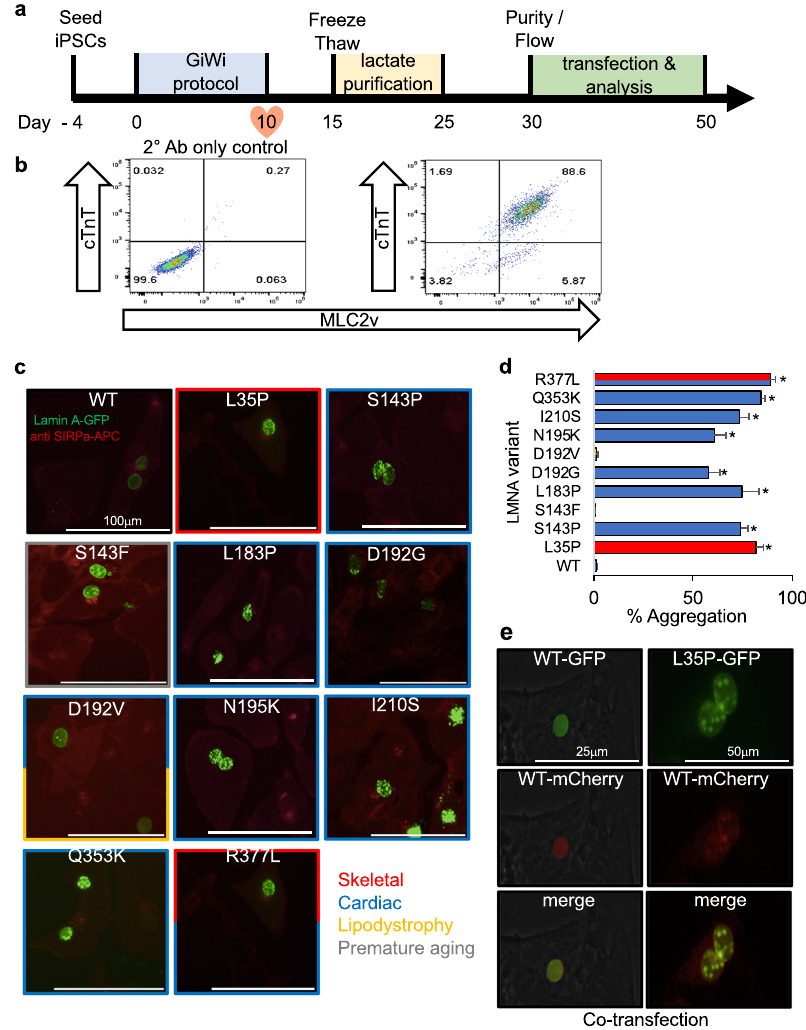
Fig. 4 Lamin A nuclear aggregation in iPSC-CMs. a A small molecule “ GiWi ” protocol was used 28 followed by lactate puri fi cation 29 to generate ( b ) ~90% pure iPSC-CMs (cTnT and MLC2v positive). c Representative images of disease-linked lamin A variants (green) overexpressed in SIRPa (cardiomyocyte surface marker) positive cells (red) showing nuclear aggregation 53 . d Bars ± SD represents the % of cells showing aggregation for all variants studied color-coded as above ( n ≥ 3). e Representative images of mCherry-WT lamin A (red) co- expressed with GFP-L35P lamin A (green). Asterisks indicate statistically signi fi cant increases in aggregation over WT ( p < 0.05). GiWi Gsk3 inhibitor: Wnt inhibitor, SIRPa CD47-signal regulatory protein